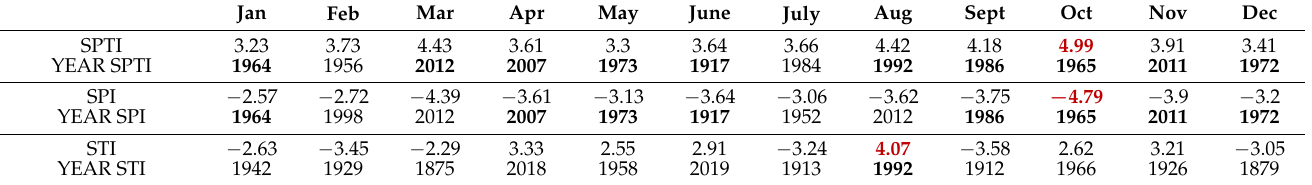
Figure 2. SPTI values, monthly and spatial average, 1871–2020; the green line indicates the significant exponential trend. Table 2. Maximum SPTI values and year of maximum, maximum SPI values and year of maximum, and maximum STI values and year of maximum for all three cases: spatial average, 1871–2020. The maximum values are marked in